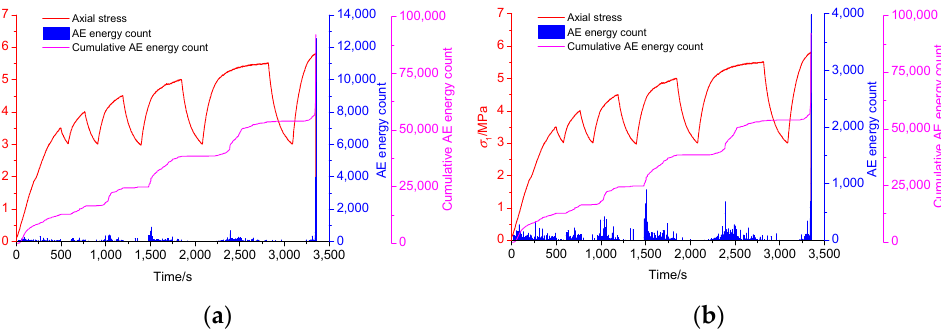
Figure 6. AE energy count and axial stress versus time curves for coal specimen subjected to cyclic loading and unloading. ( a ) AE energy count scale not magnified; ( b ) AE energy count scale magni- fied ~4×.